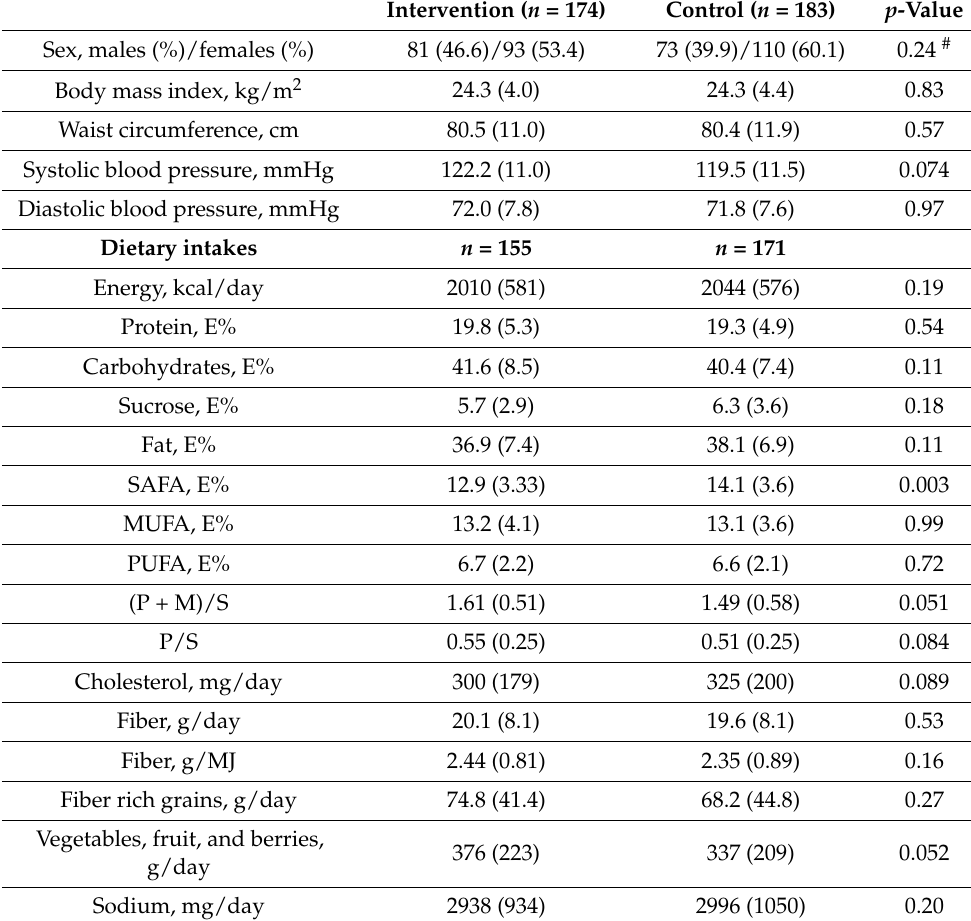
Table 1. Cardiometabolic risk markers and dietary measures of the participants six years post- intervention by intervention or control group ( n = 357; age 26 years). The presented values are mean (SD), except for triglycerides, insulin, and HOMA-IR, for which median (IQR) are shown, and for smoking, where prevalence of daily smokers is reported (%). p -values are adjusted for sex. Intervention ( n =